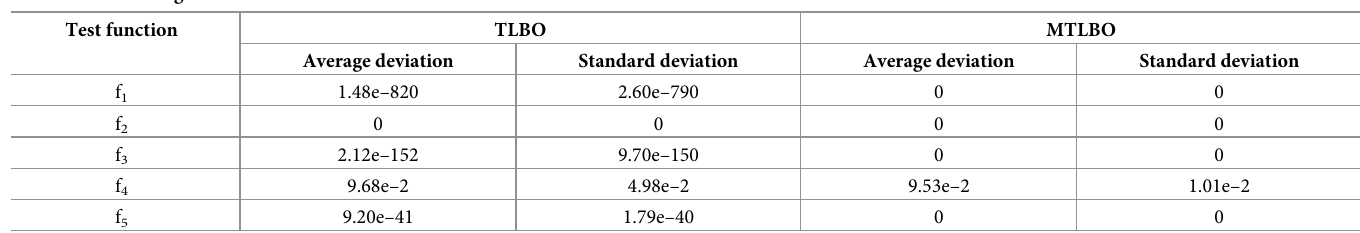
Table 4. MTLBO algorithm simulation results.